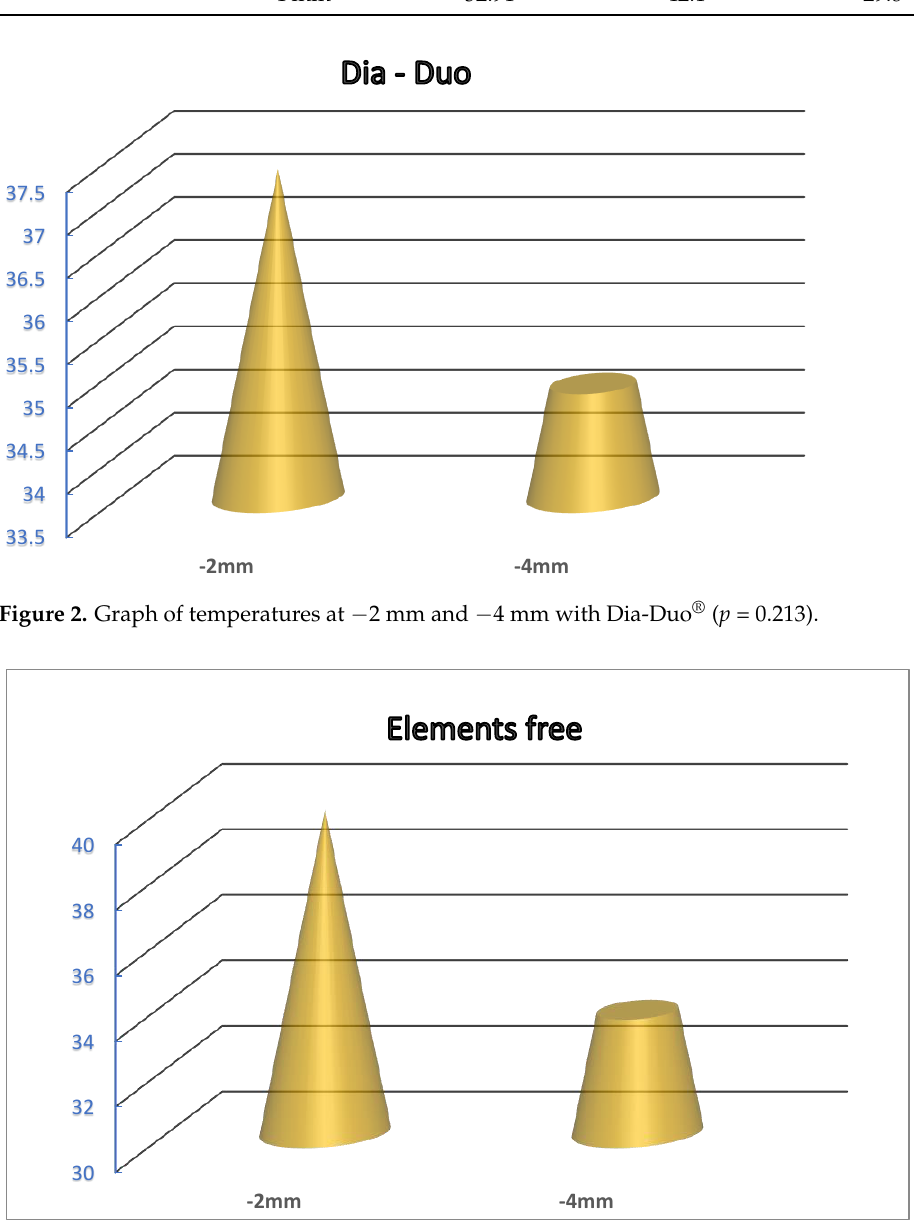
Figure 3. Average temperatures at − 2 mm and − 4 mm with Elements Free ® ( p =